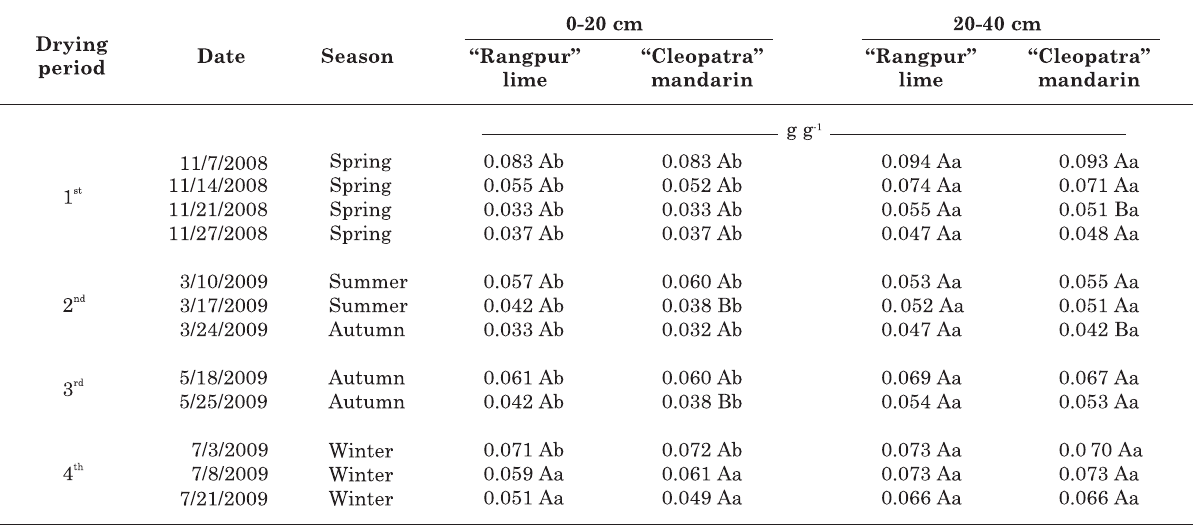
(1) Means of rootstocks followed by the same capital letter for the same date and depth did not differ by the Tukey test (p < 0.05), and by the same lower-case letter on the same date did not differ by the t test (p <